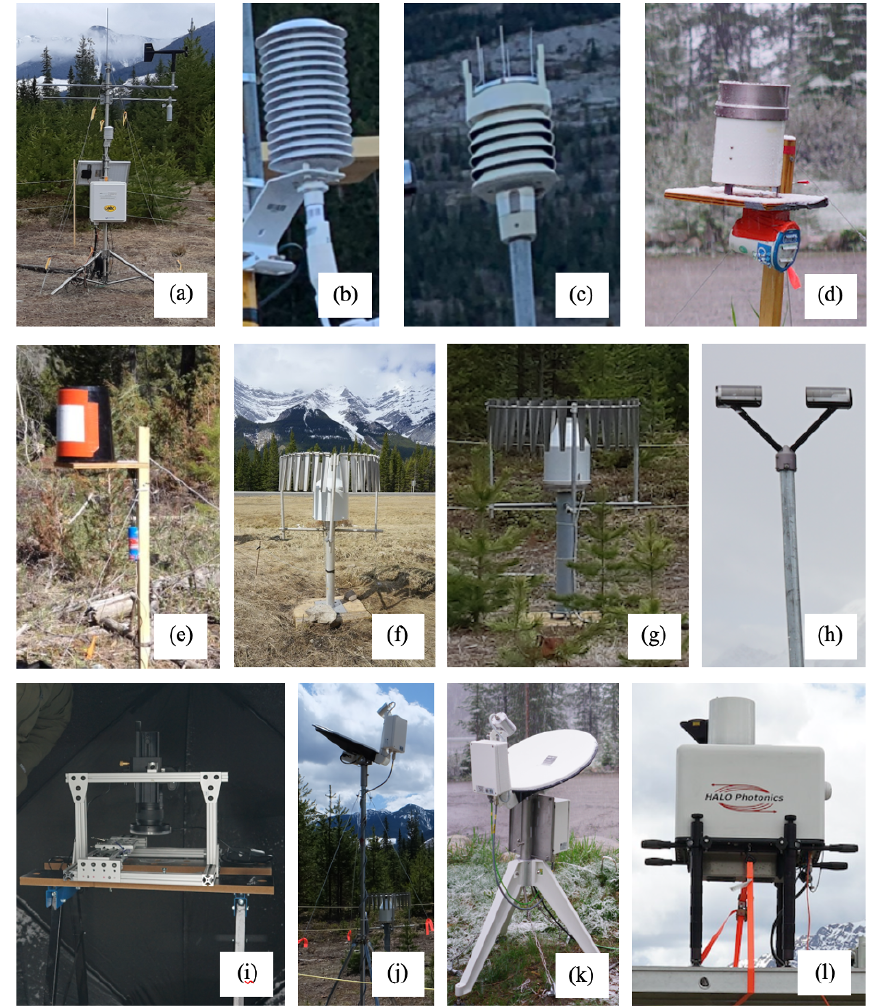
Figure 3. Photos of the instruments used in the field campaign. (a) Weather station, (b) HMP155, (c) WXT520, (d) HOBO tipping bucket, (e) Davis tipping bucket, (f) Pluvio, (g) Geonor, (h) optical disdrometer, (i) microphotography, (j) MRR-2, (k) MRR-PRO, and (l)